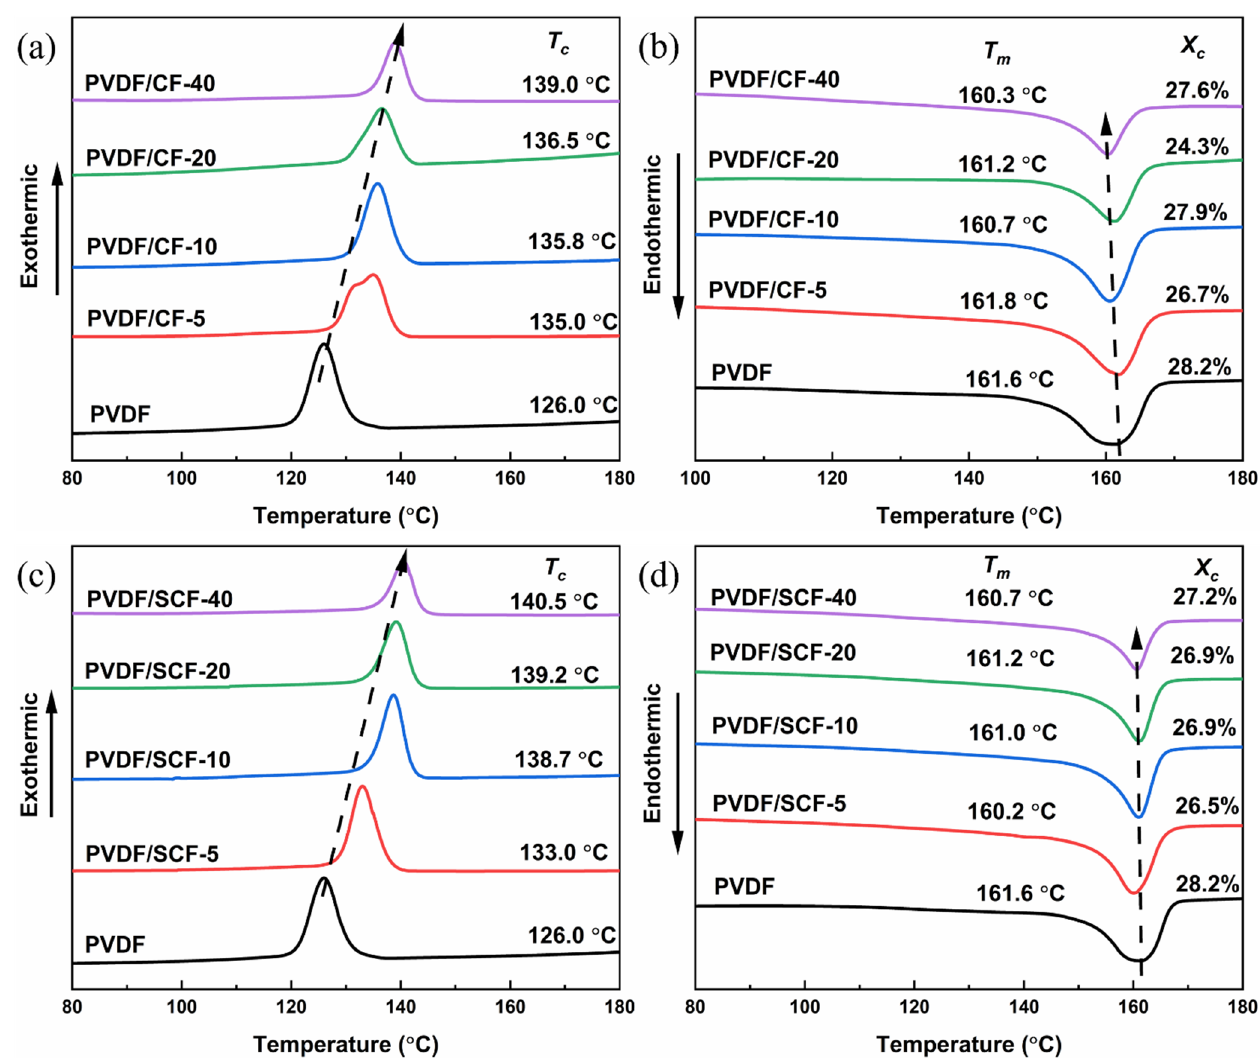
Figure 7. DSC cooling ( a , c ) and heating ( b , d ) curves of the samples.